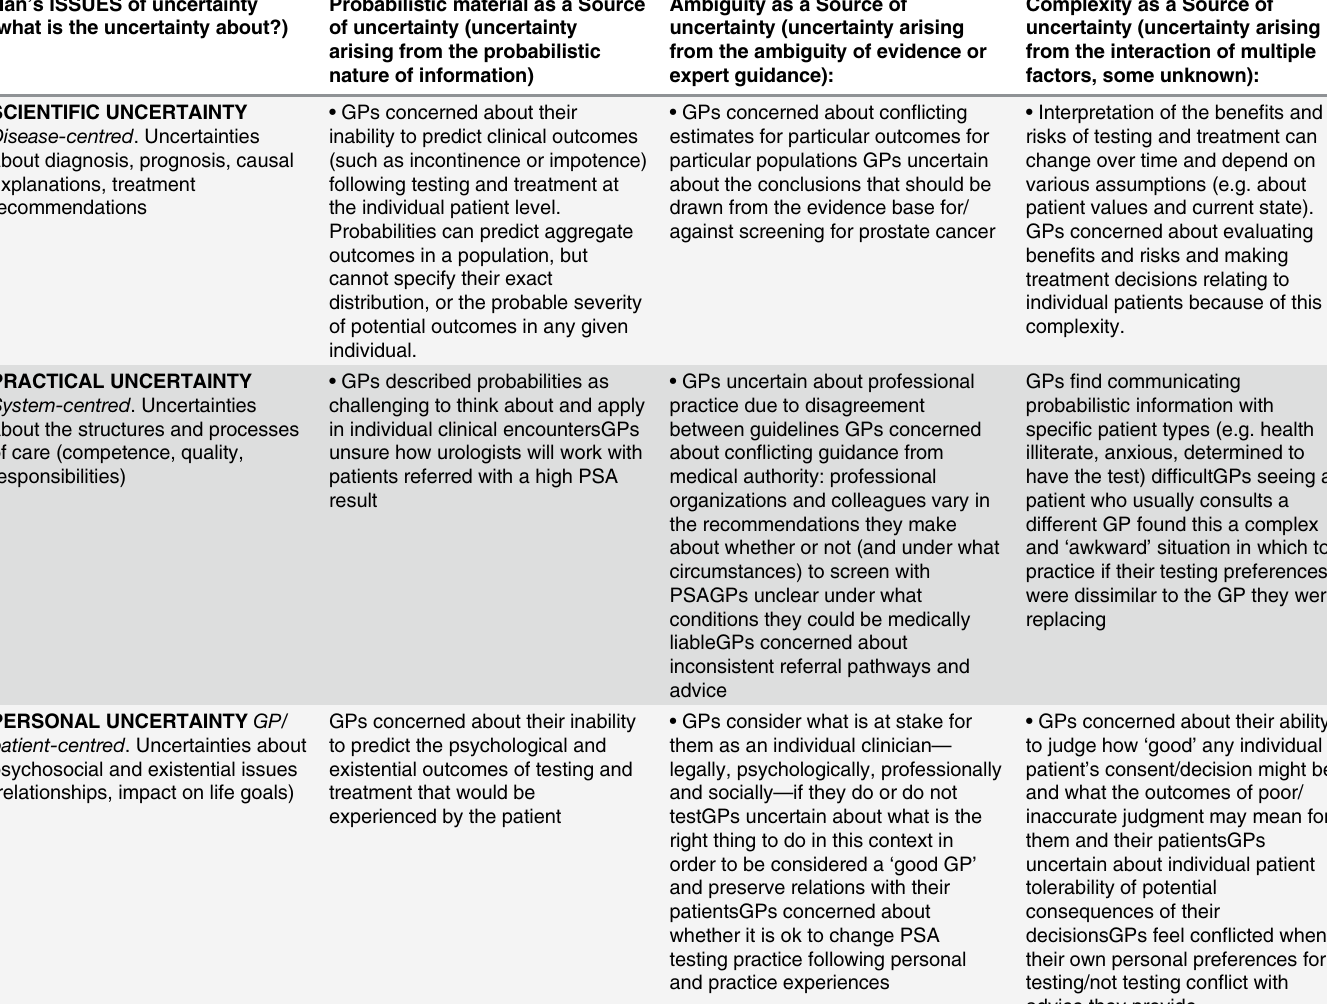
Table 2. Issues of uncertainty (what is the uncertainty